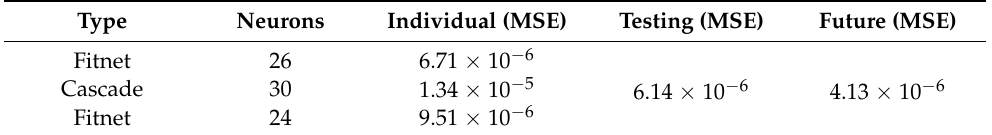
Table 9. Best architecture for